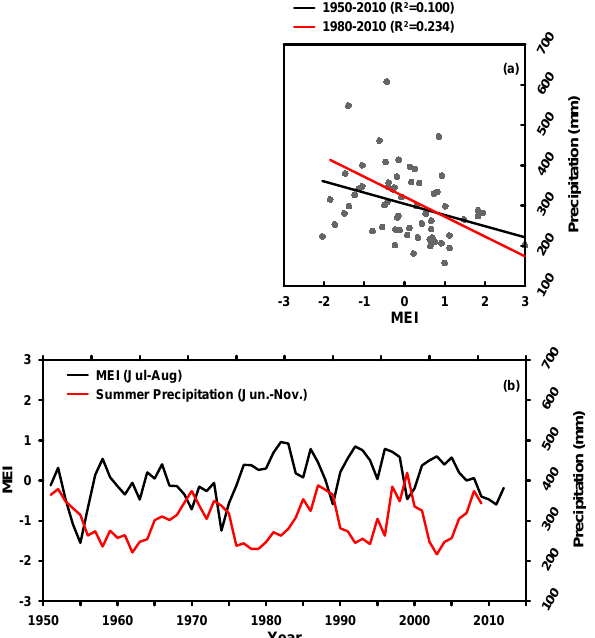
Figure 2. (a) Diagram shows statistic relationship between ENSO index (MEI) and monthly precipitation of typhoon season (June– November). (b) The recent 60year (1950–2010) mean precipitation data of typhoon season from the Ilan weather station overlaps with the MEI (Wolter and Timlin,